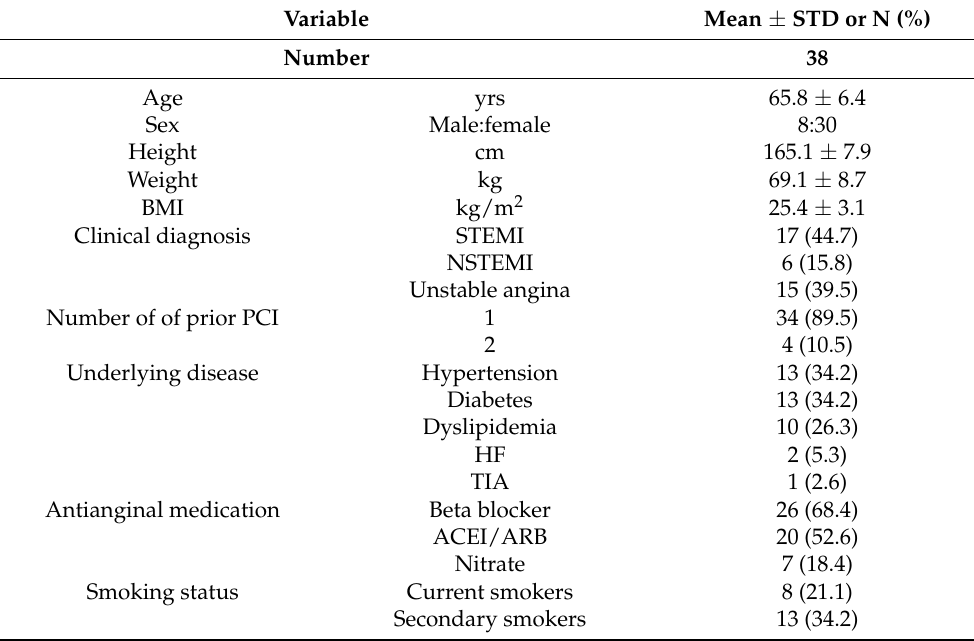
Table 1. Characteristics of study participants.